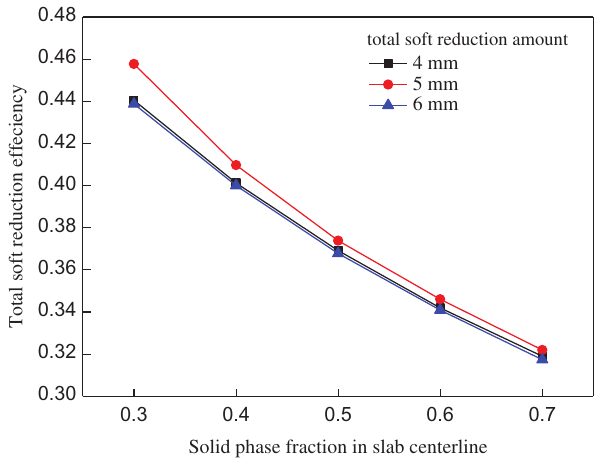
Figure 14: Relationship between total soft reduction efficiency and solid phase fraction in slab